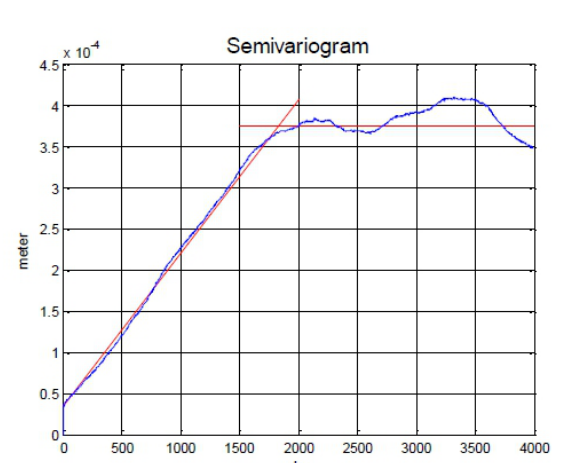
Figure 6. Covariance function determined from real GPS height observations, one registration per minute (Tantolunden, Stockholm, 2011, Leica 1200 GPS receiver). Black: First-order fitted Gauss-Markov covariance func- tion. Red: 95 % confidence level. Blue: Raw, empirical ˆ r ( k ) values.